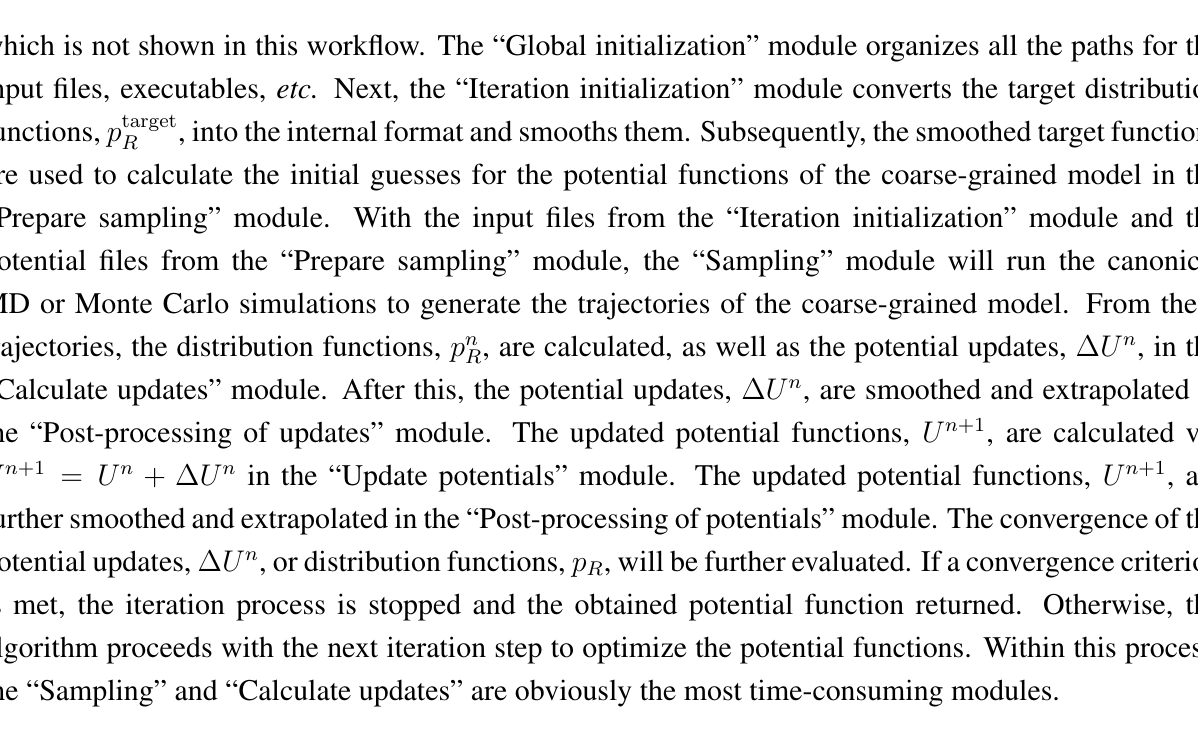
Global initialization Iteration initialization Prepare sampling Sampling Calculate updates poten(cid:2)alsPostprocessing